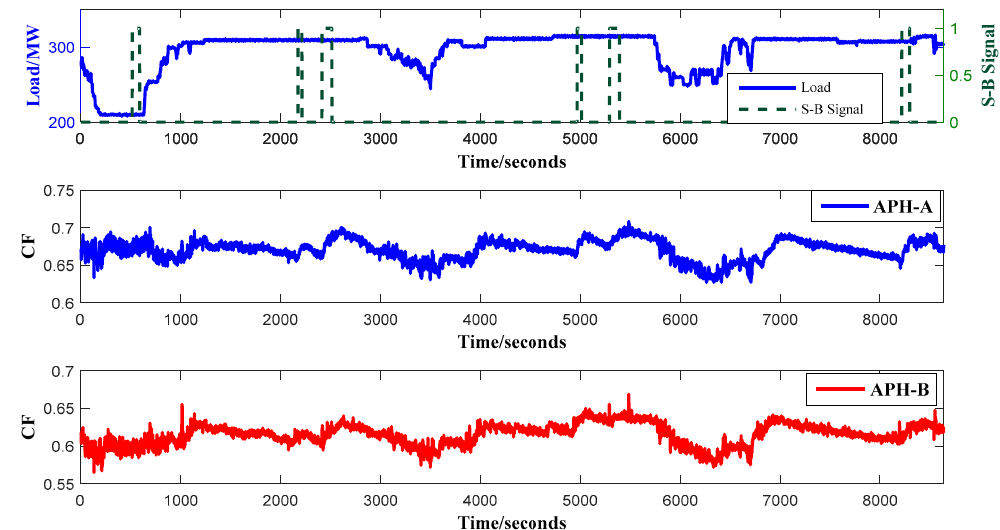
Figure 4. Monitoring results of Cleanliness Factor (CF) curves in air preheater-A (APH-A) and air preheater-B (APH-B), with some examples of different operational conditions.